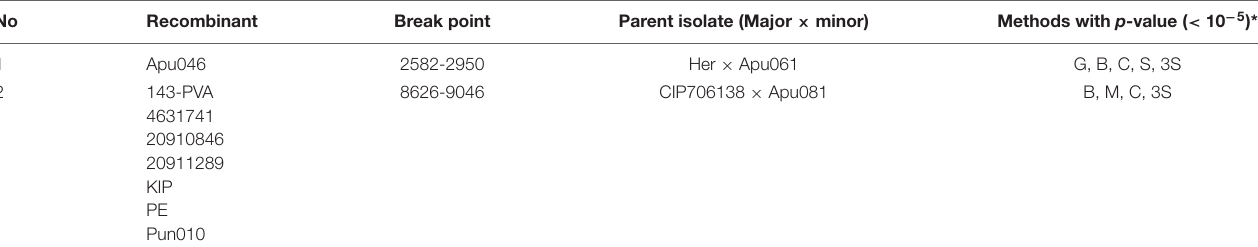
TABLE 4 | Recombination events detected in the genome of potato virus A by RDP4 Suites.